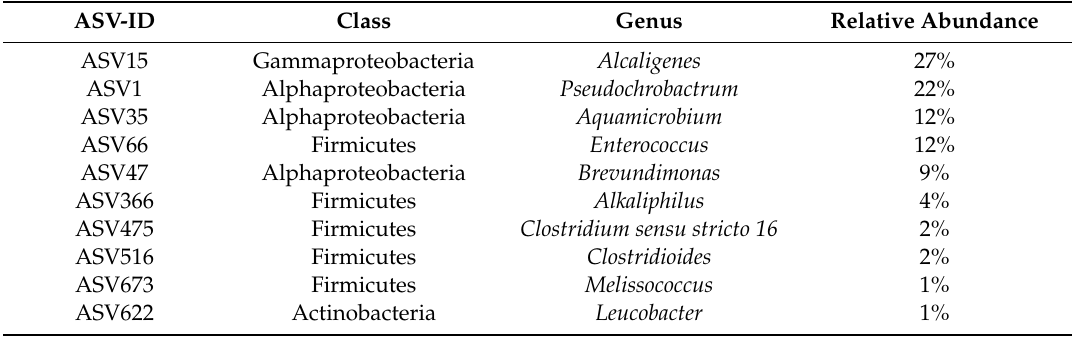
Table 1. The abundance pattern of dominant amplicon sequence variants (ASVs) in the community C1. Only ASVs detected at a frequency > 1% are